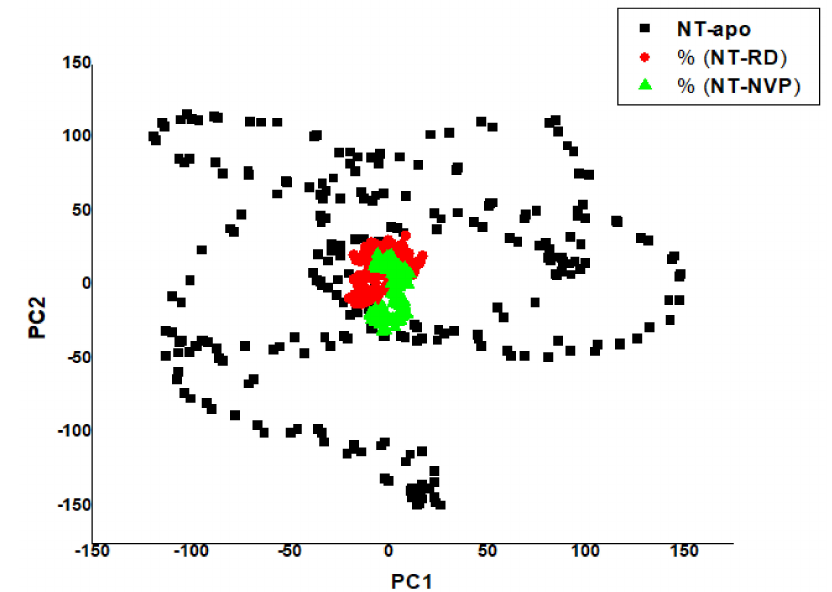
Figure 9. Projection of PC1 over PC2 for NT-apo, NT-RD and NT-NVP